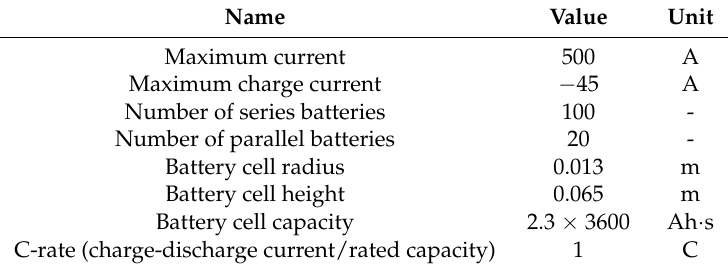
Figure 6. Power battery cell open circuit voltage-SOC curve. Table 5. Battery values. Table 5. Battery values.